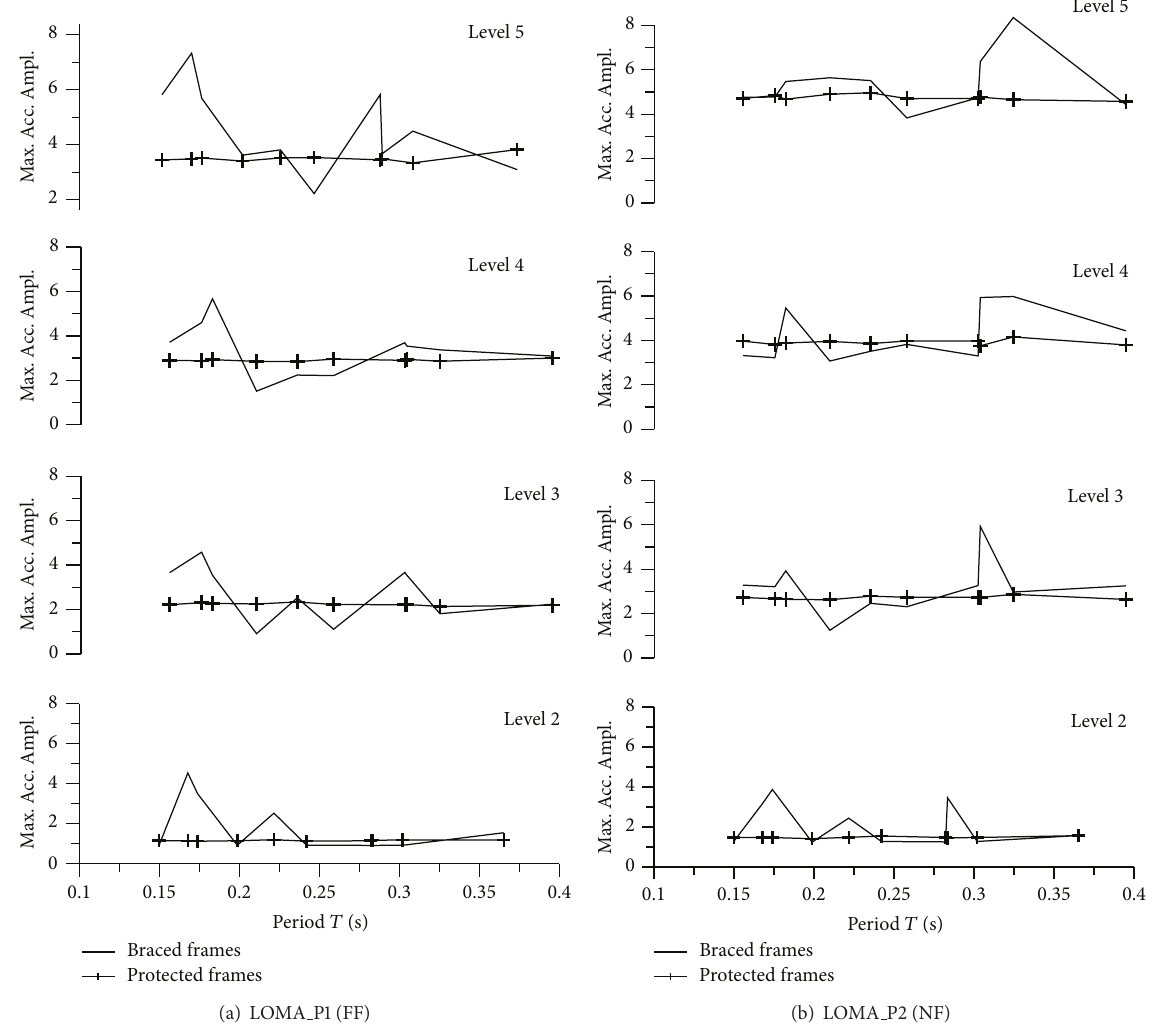
Figure 6: Maximum amplification for the 10 frames subjected to (a) LOMA P1 (FF) record and to (b) LOMA P2 (NF) record.